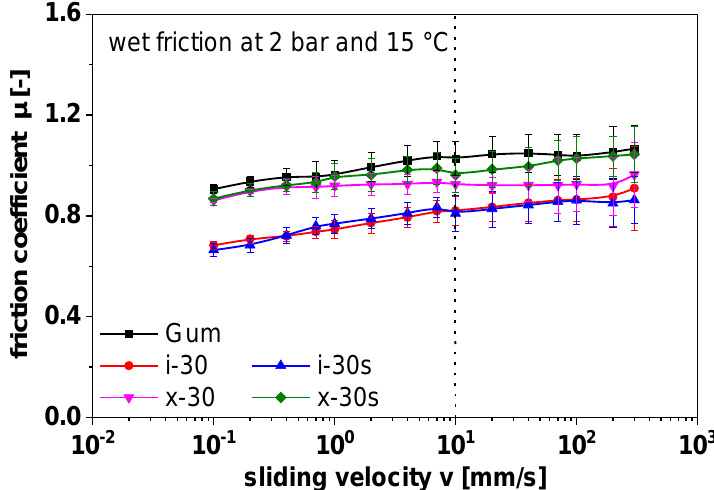
Figure 5. Friction behavior of unfilled rubber, in-situ silica, and precipitated silica with and without addition of a silane coupling agent. The dotted line corresponds to ABS wet braking conditions at 40 °C and a slipping velocity of 1 m/s.